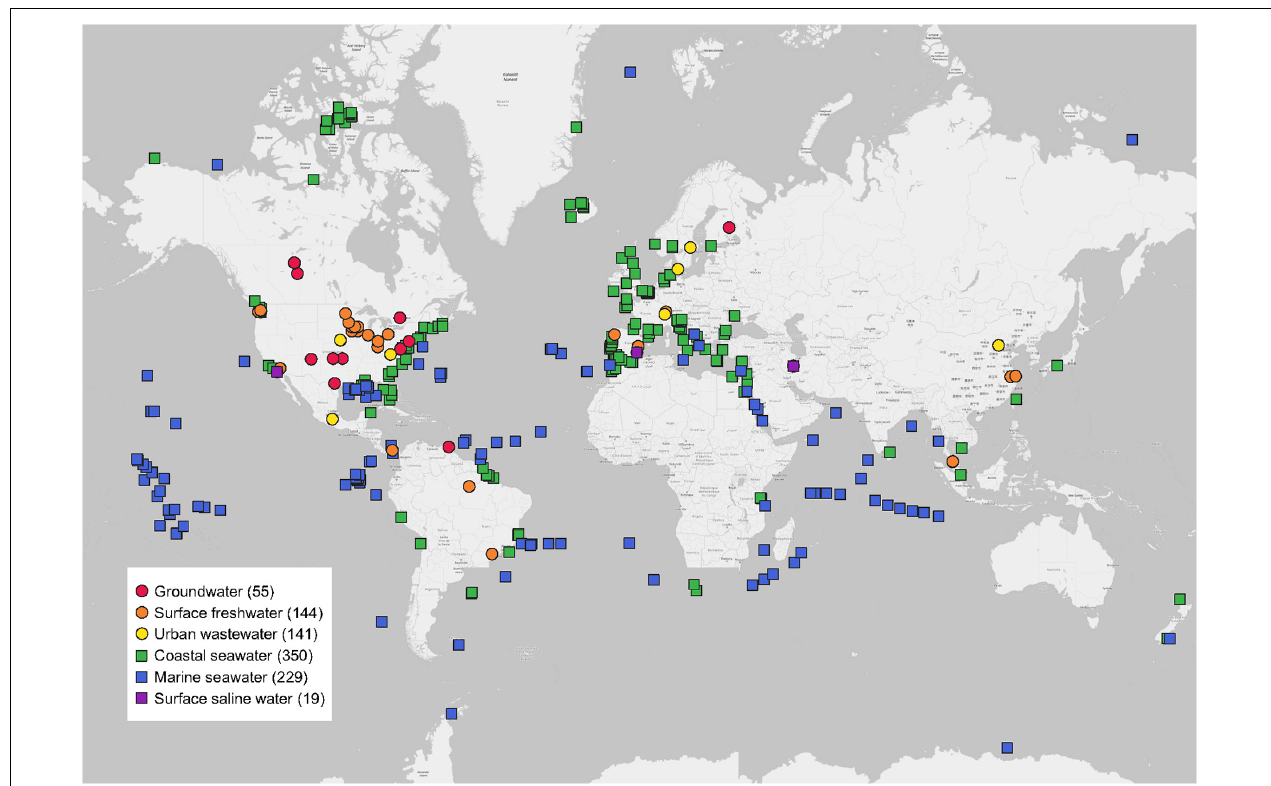
FIGURE 1 | Global distribution of water metagenomes. Locations are grouped into six water biomes from 55 publications used in this study. Sample sizes of each are given in